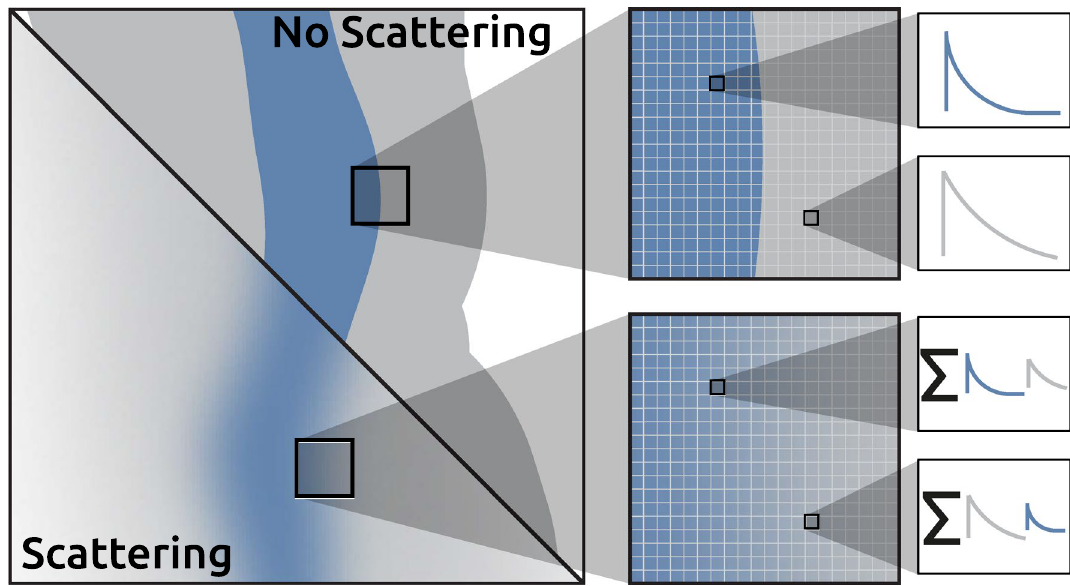
Figure 1. The upper part shows a case where there is no scattering, the short (blue) and long (gray) fluorescence lifetimes in the detector plane can be correlated to a specific location in the image plane. With the effects of scattering shown in the lower part of the figure, the contribution from nearby areas in the image plane will contribute to the detected luminescence lifetime in the detector plane such that the spatial resolution is decreased. The signal in these pixels will be a sum of signals from nearby